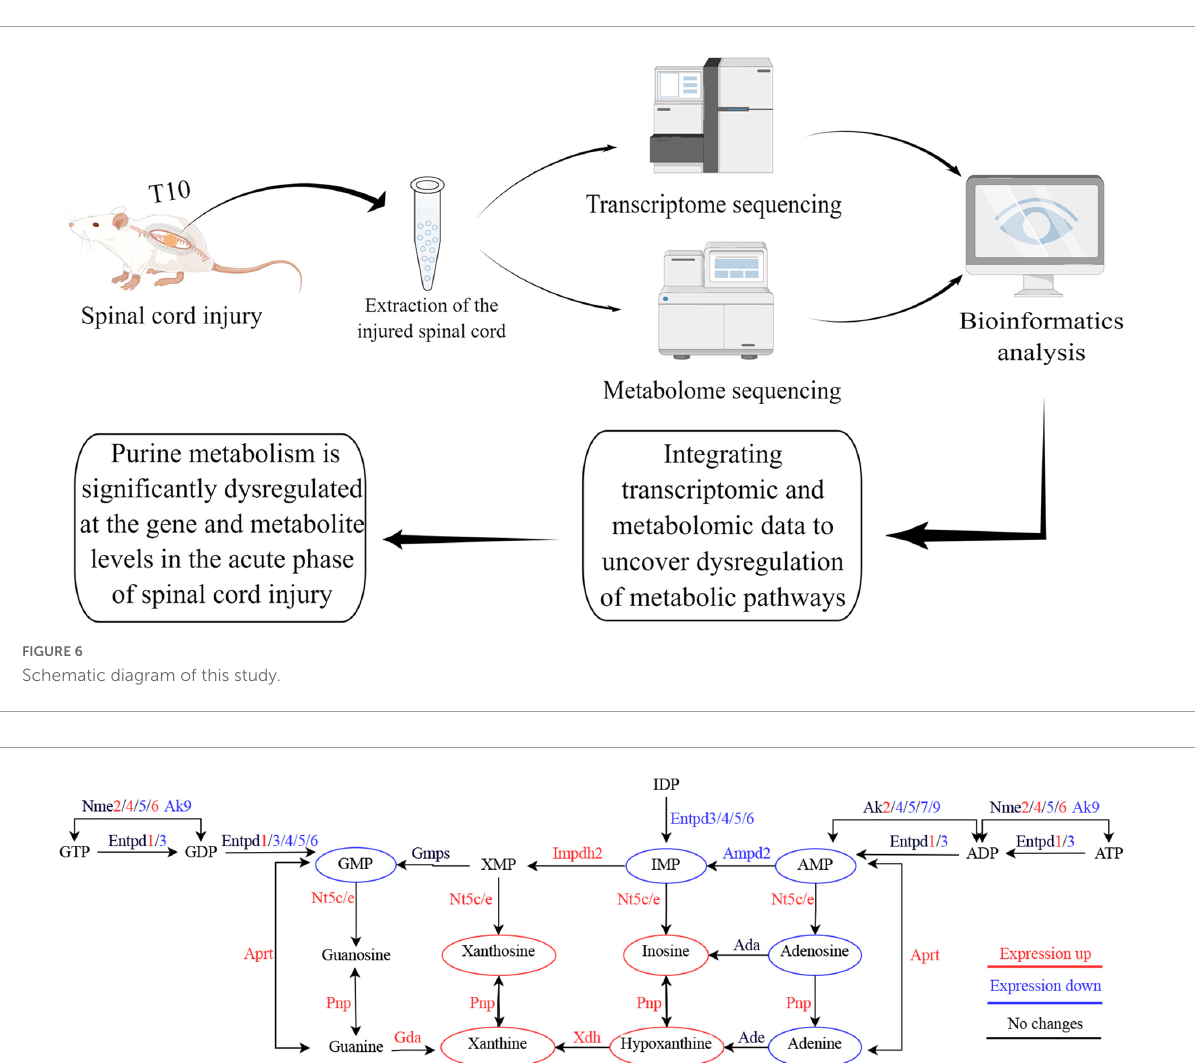
FIGURE7 Simplified diagram of purine metabolism dysregulation in the acute phase of spinal cord injury.